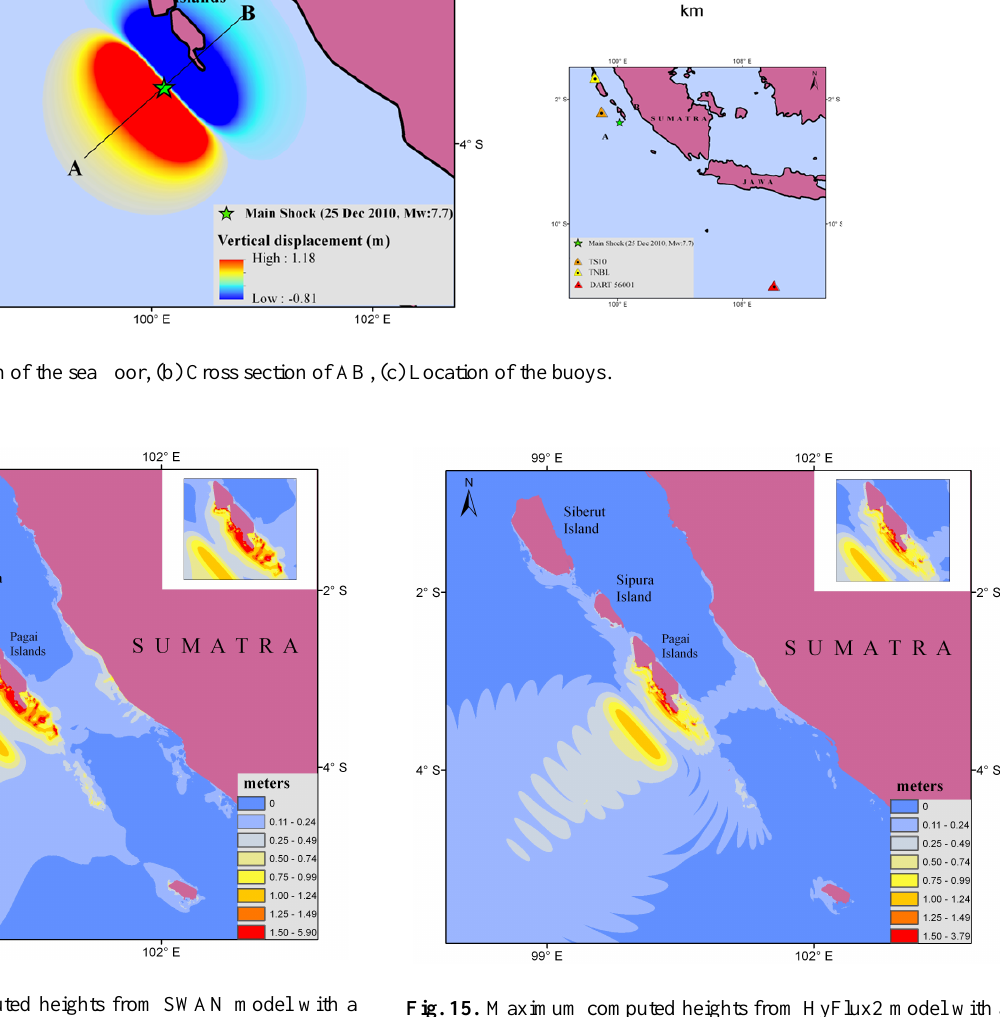
Fig. 15. Maximum computed heights from HyFlux2 model with a cell size of